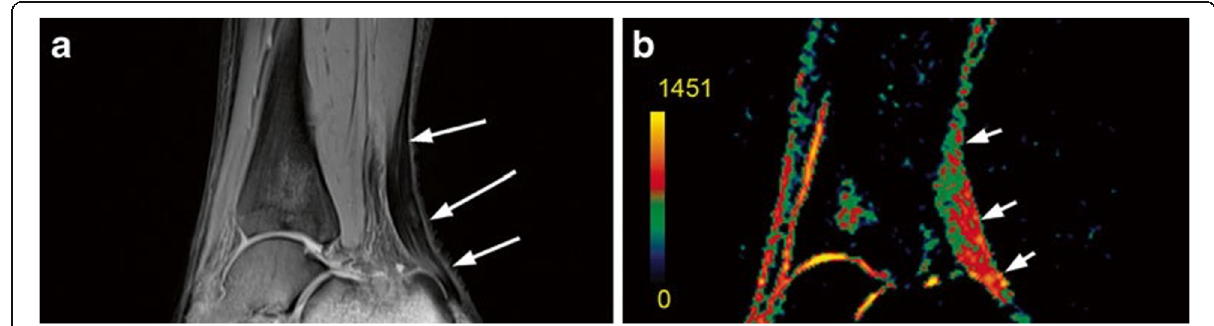
Fig. 6 MRI of a 46-year-old patient with chronic Achilles tendinopathy. a Proton-density-weighted two-dimensional turbo spin-echo image depicts centres of each region of interest (arrows). b Corresponding colour-coded three-dimensional gradient-echo sodium image depicts Achilles tendon sodium signal (arrows), which is obviously higher than that in the healthy volunteer. The sodium signal increase was observed in the whole tendon, and not only in regions with clinical findings (middle region in this case). All patients had focal thickening of the Achilles tendon without fluid-like signal intensity increase on proton-density – weighted two-dimensional turbo spin-echo images. Colour scale represents sodium signal intensity